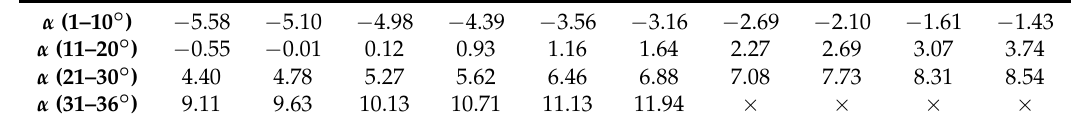
Table 3. The index of 36 test samples.